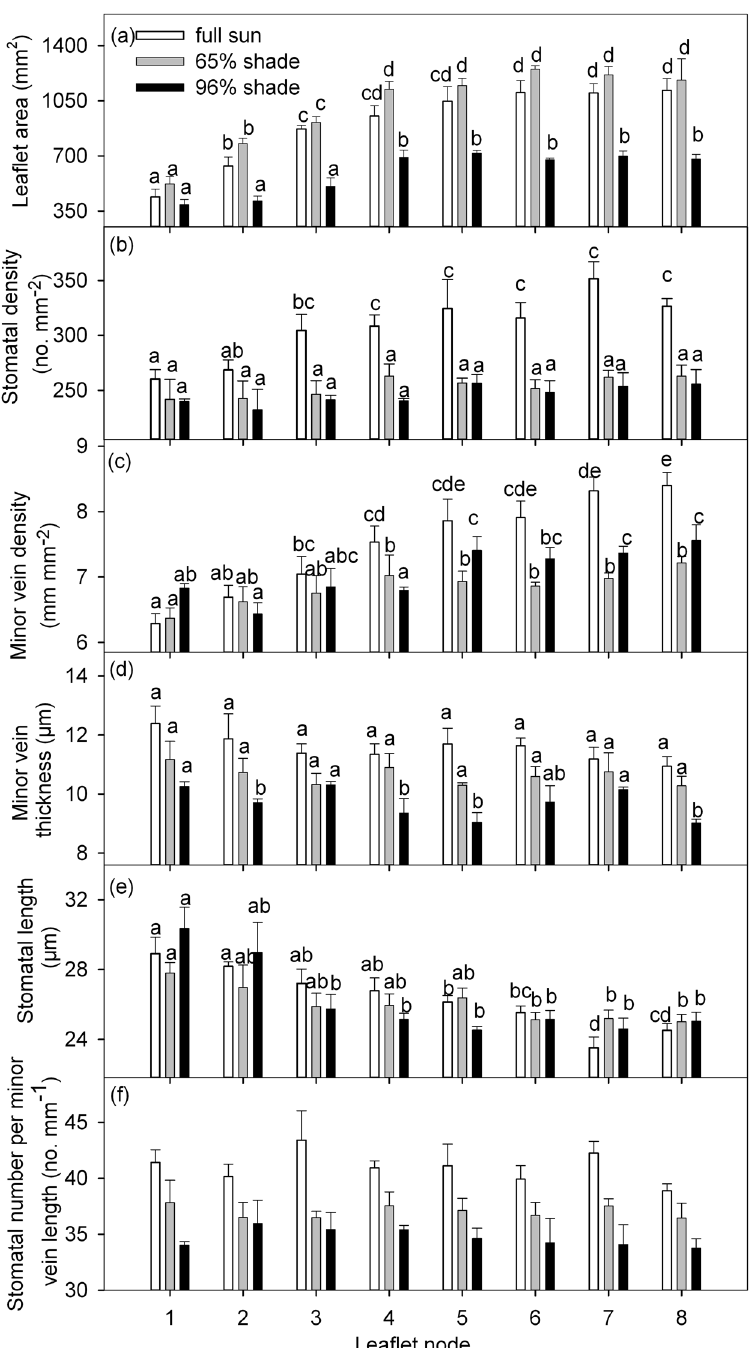
Figure 1. Leaflet area ( a ), stomatal density ( b ), minor vein density ( c ), minor vein thickness ( d ), stomatal length ( e ) and stomatal number per minor vein length (SV, f ) of the apical leaflet from the first to eighth leaf in node on peanut plants grown in three light conditions. Different lowercase letters in each panel indicate a significant difference in the traits of plants in the same light condition ( P < 0.05). Under each light condition, SV did not significantly change with the leaf node ( f